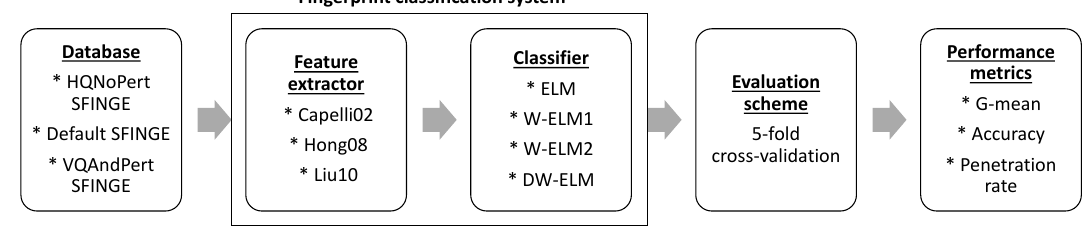
Figure 5. Outline of the methodology where the proposed fingerprint classification system is